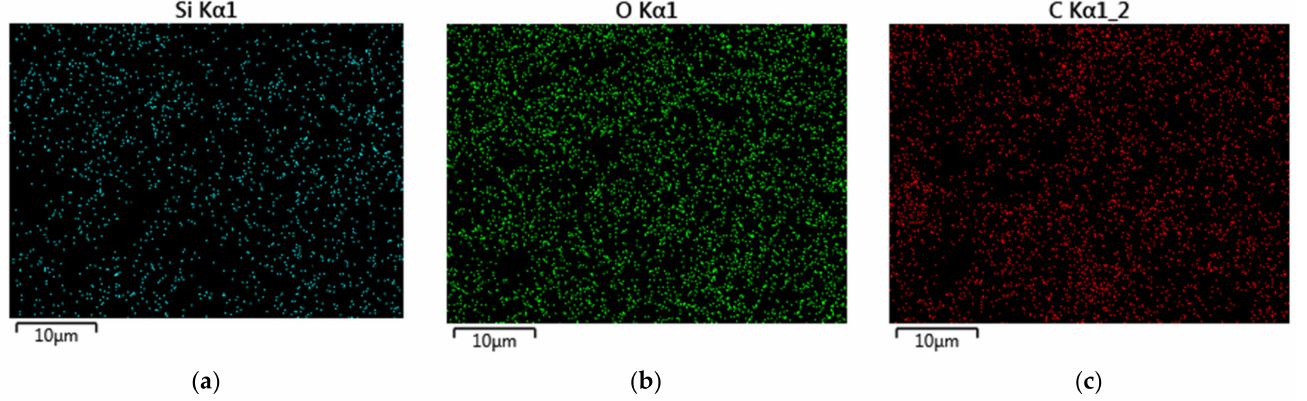
Figure 4. EDS elemental maps of microdomain of the sol–gel matrix containing 50% DEDMS and immobilized microorganisms: ( a ) silicon; ( b ) oxygen; ( c )